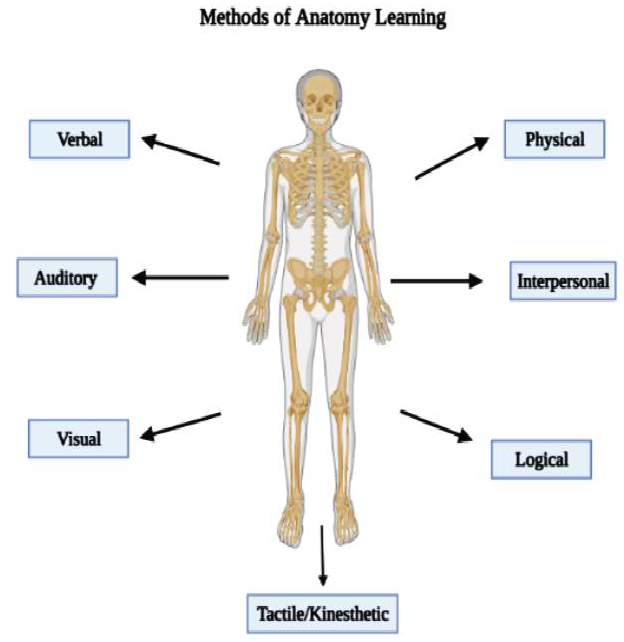
Figure 1. Methods of anatomy learning.